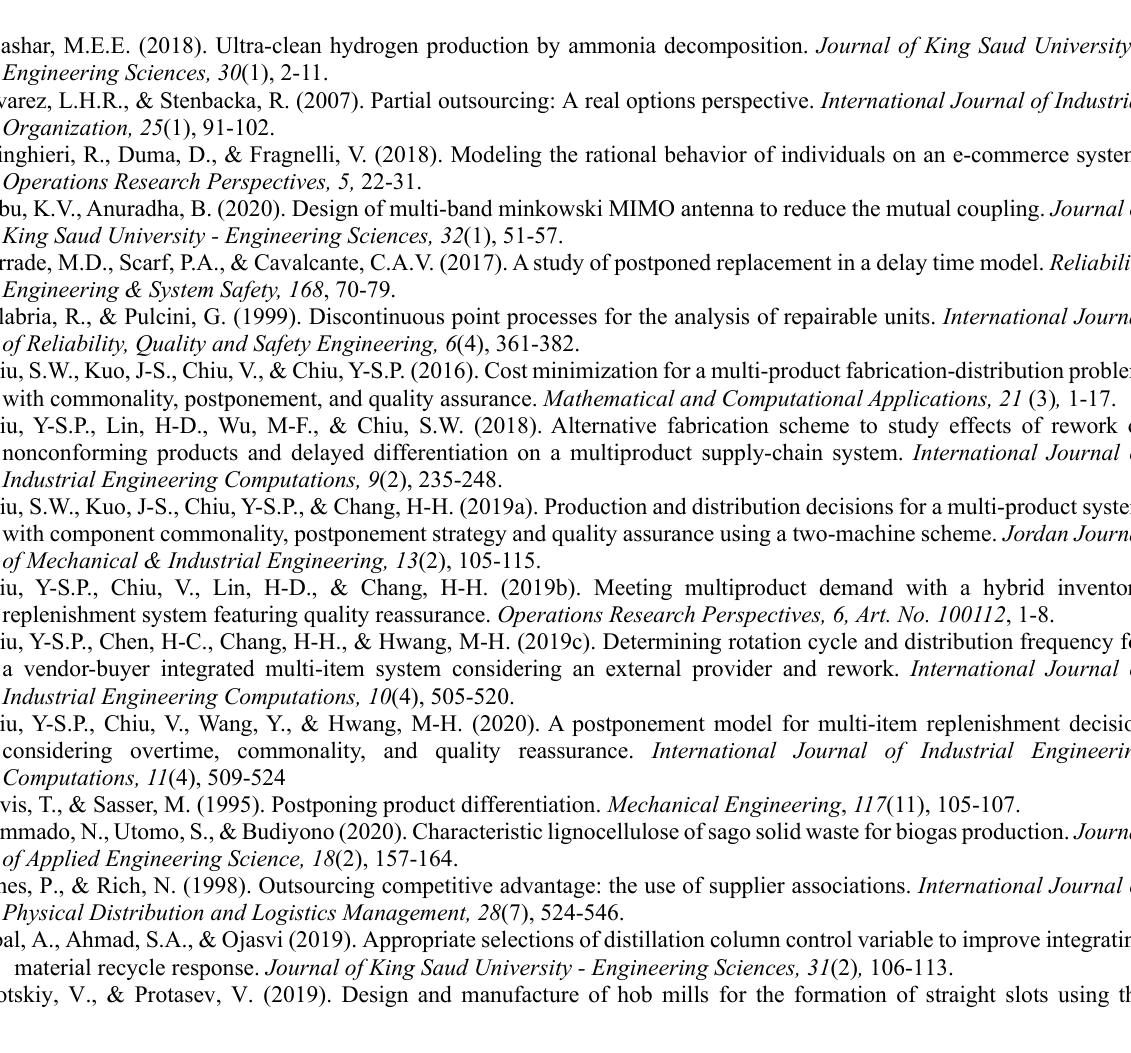
Fig. 17. Comparison of E [ TCU ( T *)] of our model with that in the similar models Fig. 17 indicates that for a reduction of 19.57% in utilization, E [ TCU ( T *)] rises to $2,138,414 from $2,028,449, which is a 5.42% increase as compared to that of Chiu et al. (2016). Moreover, for a decline of 22.88% in utilization, our model pays the price of 0.65% in E [ TCU ( T *)] increase, as compared to a no delayed-differentiation fabrication